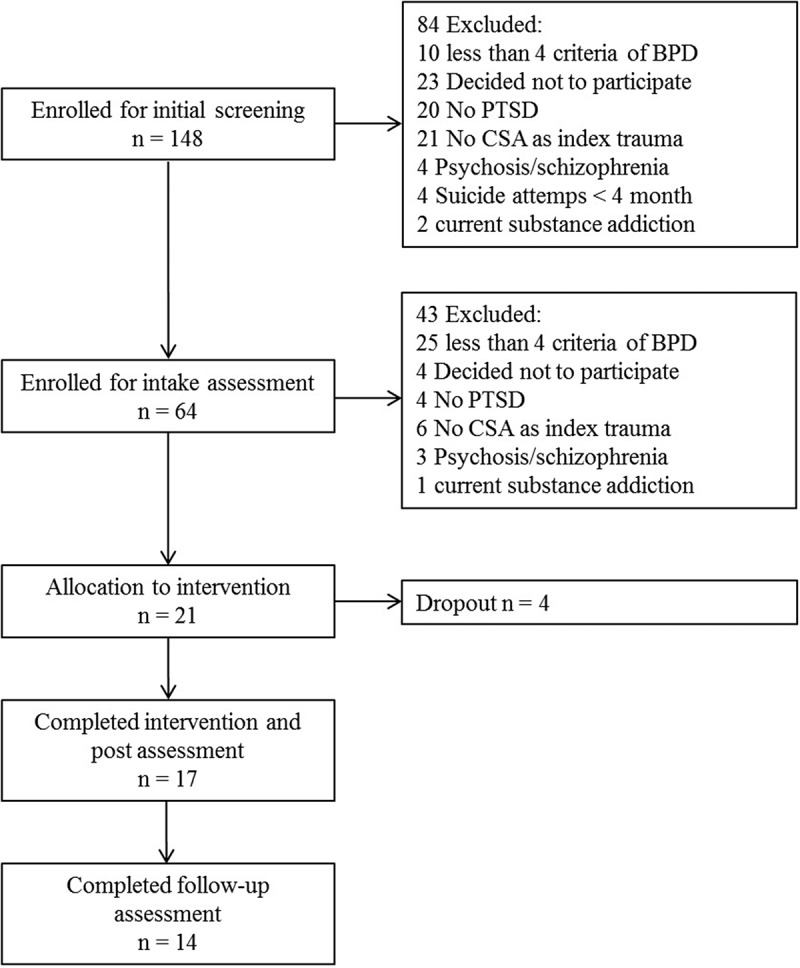
Patient flow chart.